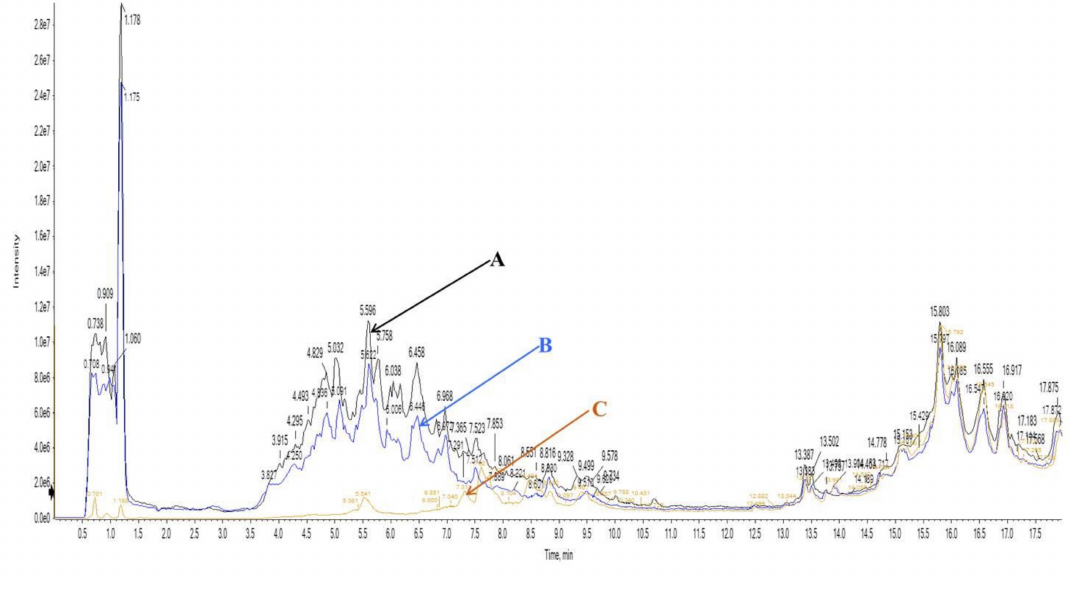
Figure 1. RP-HPLC chromatograms of various stages of sample preparation: ( A ) represents the chromatogram of raw soy protein isolates (SPI), ( B ) represents the Prozyme treated SPI and ( C ) represents the product